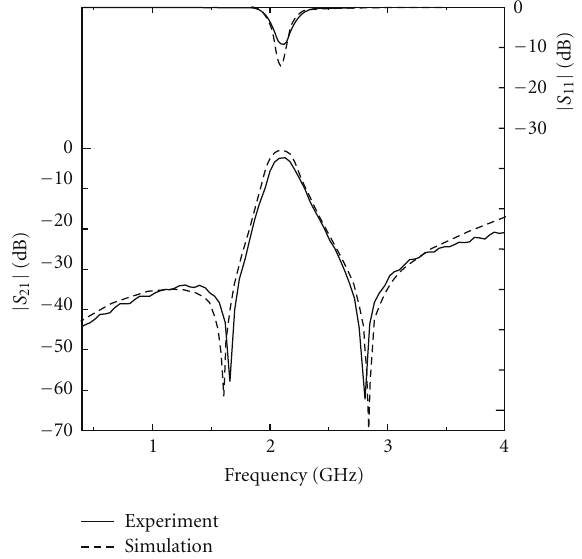
Figure 13: Frequency characteristics of scattering parameters ( a = 5 . 2mm and d = 1 . 0 mm (Figure